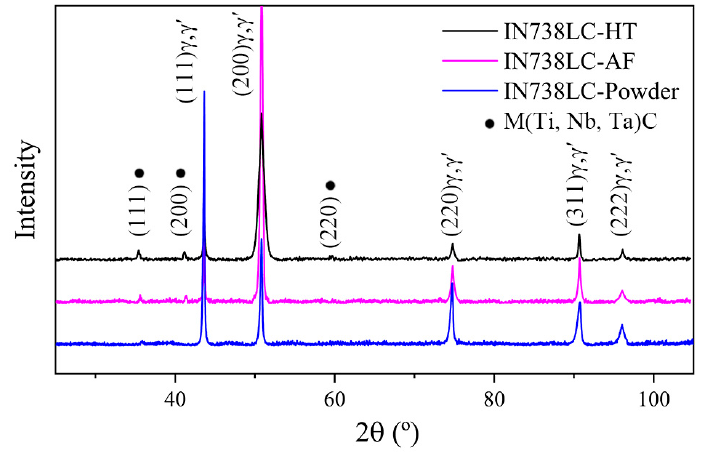
Figure 7. XRD results of the IN738LC powder, AF and HT samples. Table 3. Peak intensity variation in XRD examination.